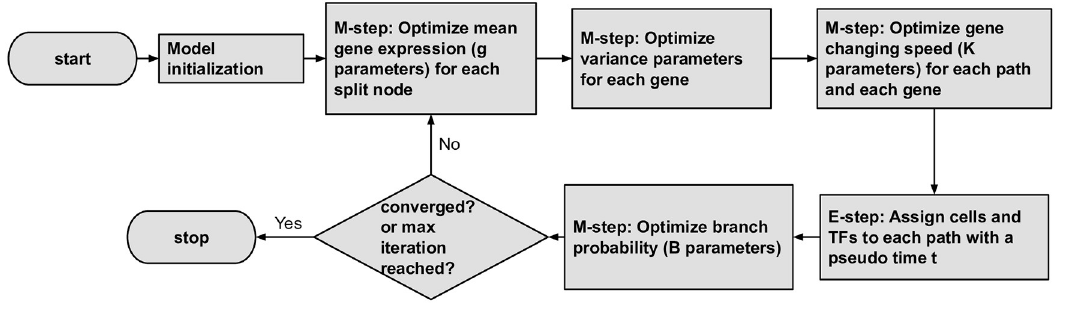
Fig 5. flow chart of how to iteratively learn